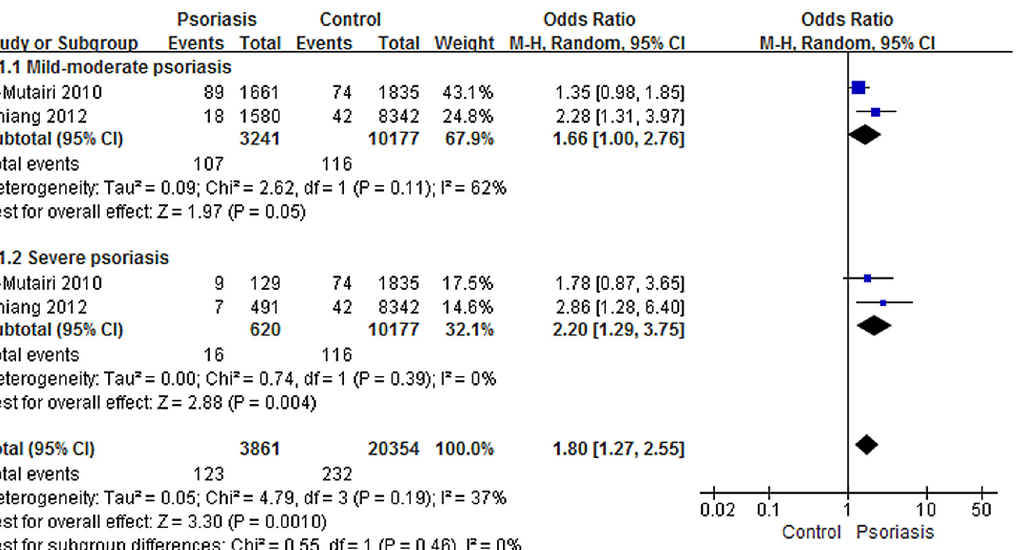
Fig 3. Meta-analysis of the prevalence of chronic obstructive pulmonary disease (COPD) in patients with mild to moderate or severe psoriasis compared with controls. “ Events ” means the number of COPD in subjects. Odds ratios (ORs) for COPD in subjects with psoriasis compared to subjects without psoriasis. The point estimate (center of each blue square) and the statistical size (proportional area of the square) are shown. Horizontal lines indicate 95% confidence intervals. The pooled ORs (diamond) were calculated using random effects model.